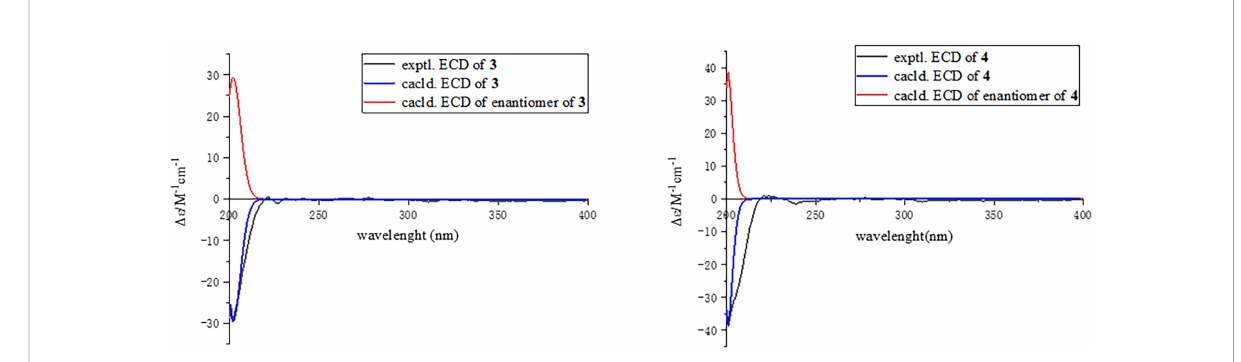
FIGURE 5 Experimental and calculated electronic circular dichroism spectra of compounds 3 and 4